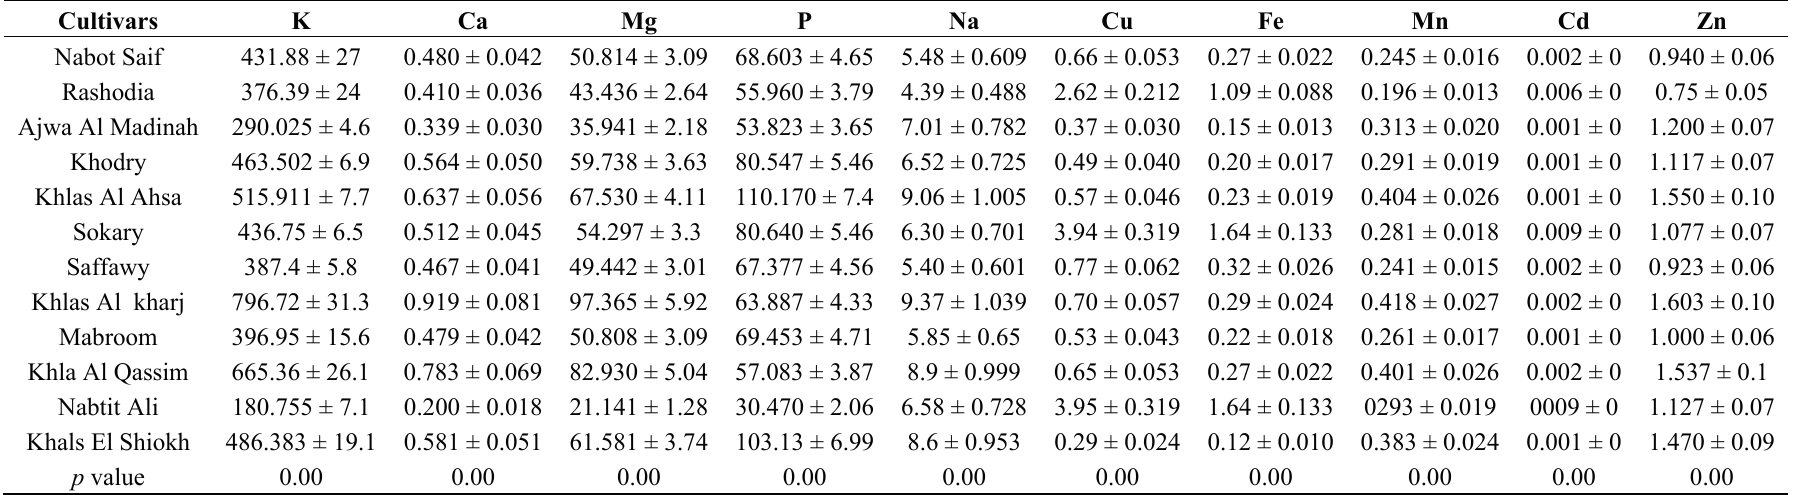
Table 6. Concentrations of minerals (mg/100 g DW) in 12 Saudi date